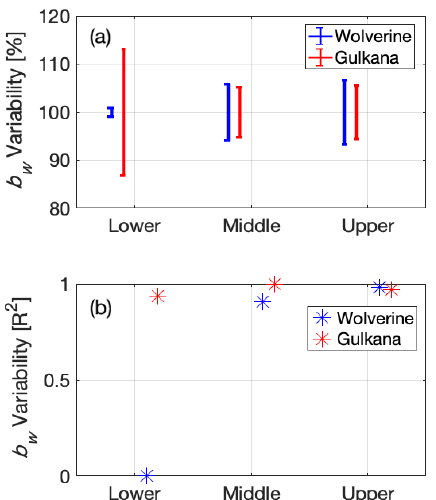
Figure 15. Interannual variability in the spatial pattern of snow ac- cumulation at long-term mass balance stake locations for Wolverine and Gulkana glaciers using (a) normalized b w range and (b) coeffi- cient of determination (from Fig. 11; MVR